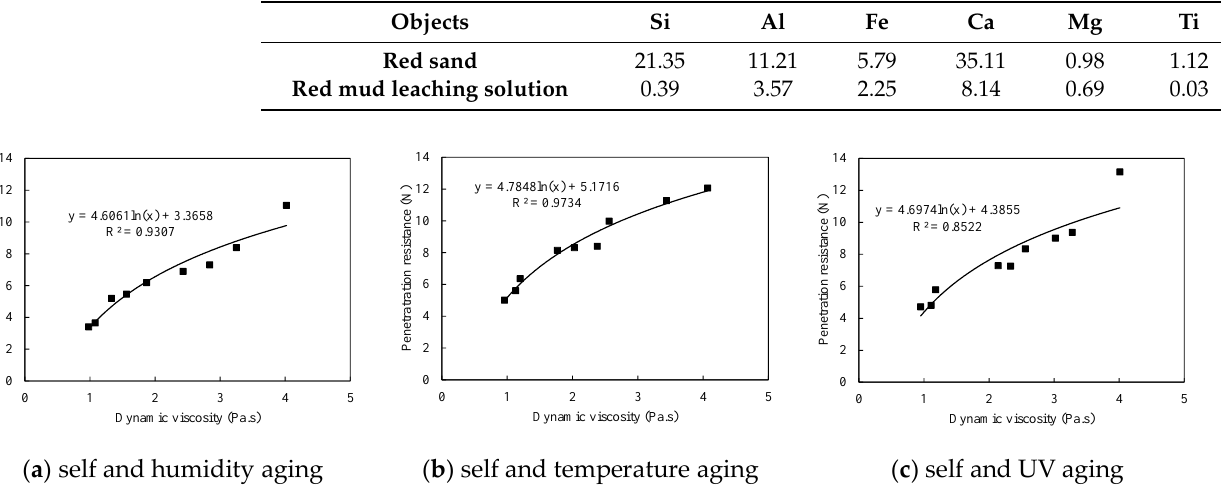
Figure 14. Penetration resistance vs. dynamic viscosity (red mud leaching solution based). Table 9. Composition of red sand powder and red mud leaching solution (wt.%).